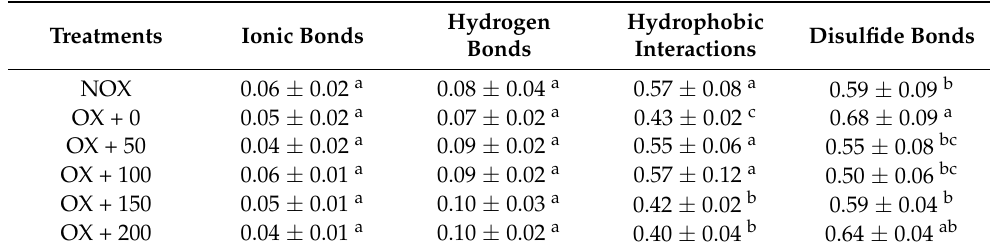
Table 5. Chemical forces of MP gels treated with various concentrations of FOs (0, 50, 100, 150, and 200 µ mol/g protein) under nonoxidizing (NOX) or oxidizing (OX) conditions. Different lowercase letters indicate significant differences ( p <